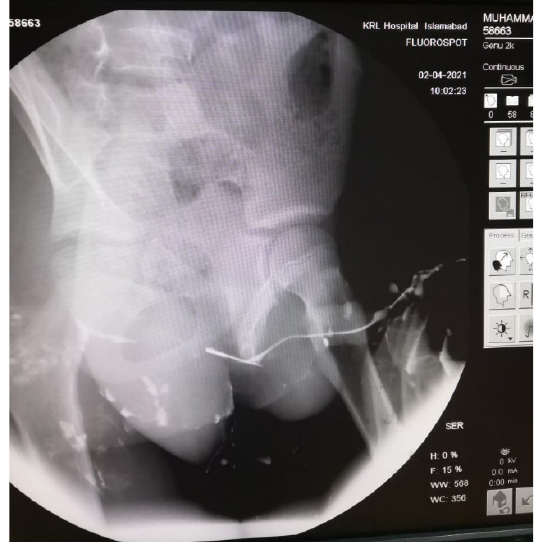
Figure 1: Micturating urethrogram showing foreign body in posterior urethra.